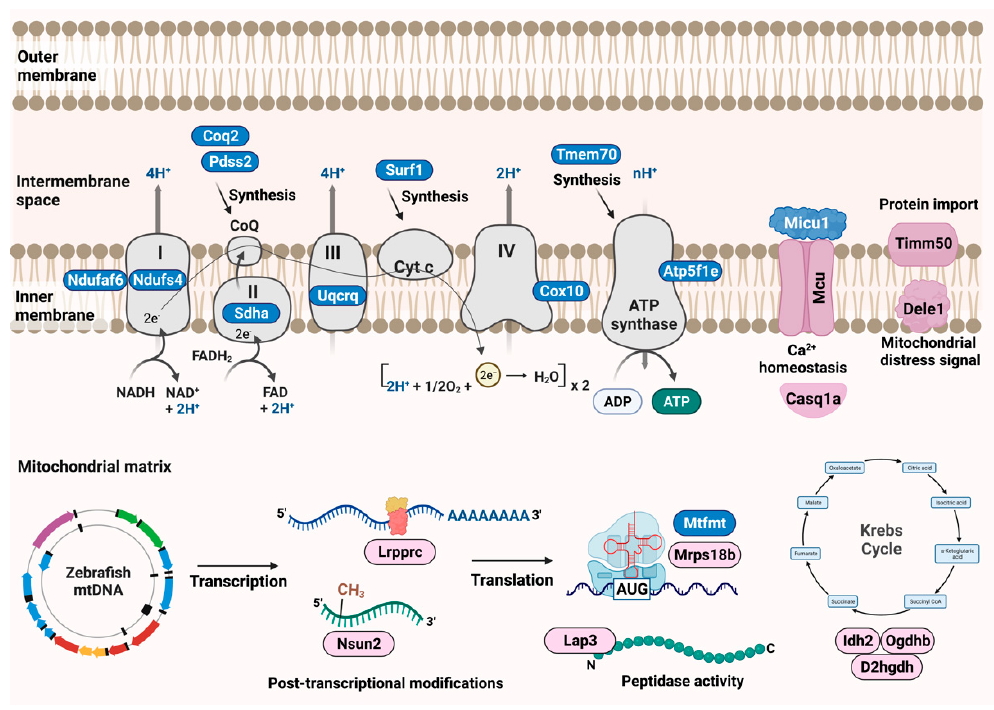
Figure 2. Zebrafish Marriott mitochondrial mutant collection: Schematic representation of various mitochondrial resident pathways for which zebrafish mutants were generated. The nuclear-encoded mitochondrial proteins have been illustrated according to the function they are involved in mitochondrial maintenance and homeostasis. Mutants generated by TALE gene editing are depicted as blue, whereas those generated by the GBT system are depicted in pink.